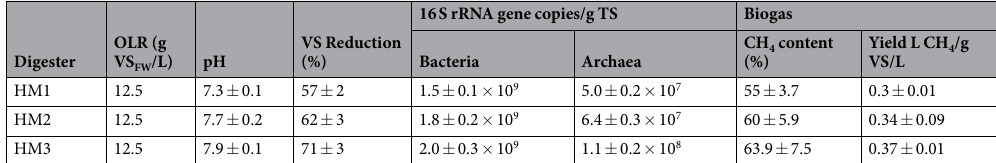
Table 2. Variations of VS reduction, pH, 16 S rRNA gene copies of bacteria and archaea, methane yields and methane content in three ADs after 60 days of operation. Values are expressed as mean value ± standard